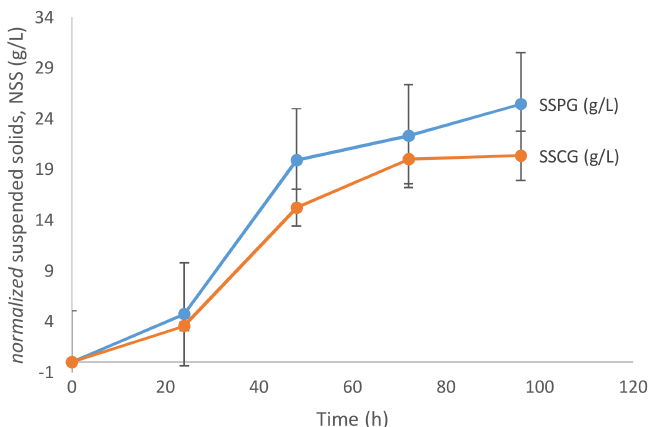
Figure 2. Net suspended solids (NSS) profile for the flask fermentation without sludge using pure glycerol (SSPG) and crude glycerol (SSCG).